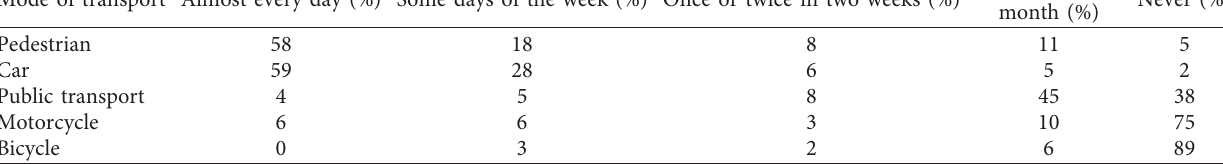
Table 8: Children’s exposure to